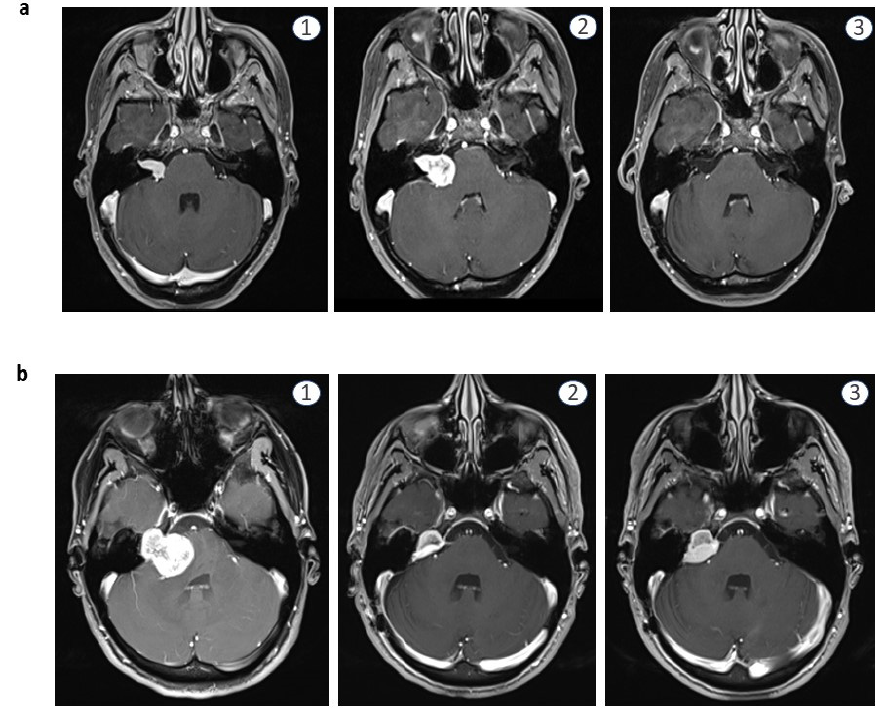
Figure 3 . Exemplary MRI images (T1 + contrast) of two patients: ( a ) 17a, male, 1 : first diagnostic